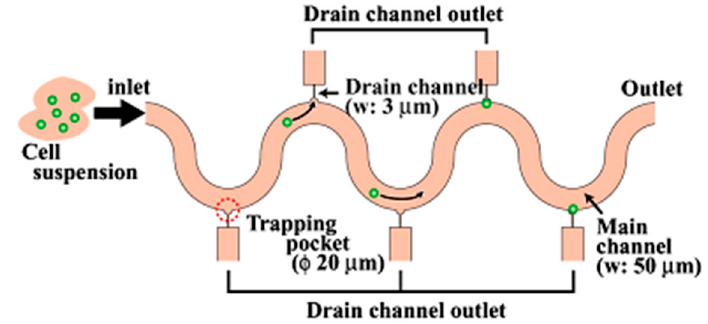
Figure 5. Trapping of single cells using the device designed by Arakawa et al. The cells can either be caught by the drain channels or continue flowing in the main channel as denoted by the arrows. “Reproduced from [62], with the permission of AIP Publishing”.